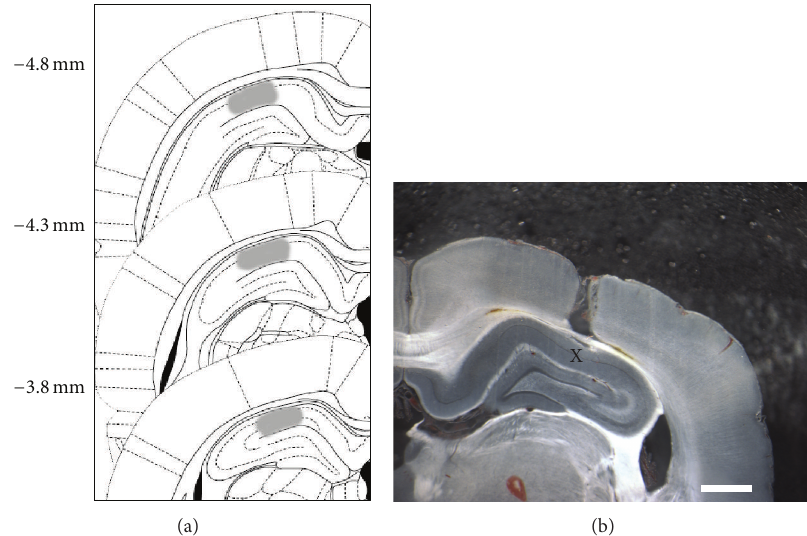
Figure3:(a)Schematicrepresentationofratbrainsectionsatthreerostrocaudalplanes(AP − 4.3 mm,LL ± 3.0mm,DV1.4mmfrombregma) taken from the atlas of Paxinos and Watson (1997). In stippling, the extension of the area reached by the infusions in the dorsal hippocampus (CA1). (b) Photomicrograph shows the placement of the cannula; the “X” indicates the place corresponding to the area of drug infusion in hippocampus. Scale bar: